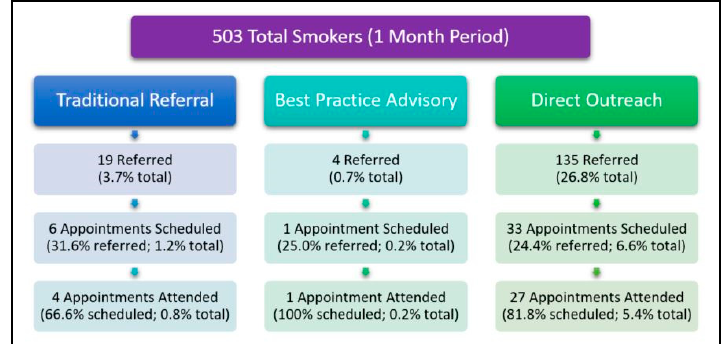
Figure 3. Referral methods (1 month).